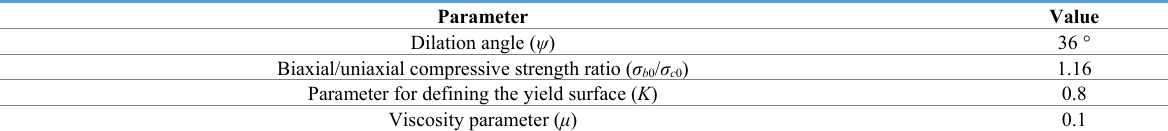
Table 1. Parameters adopted in CDP model.